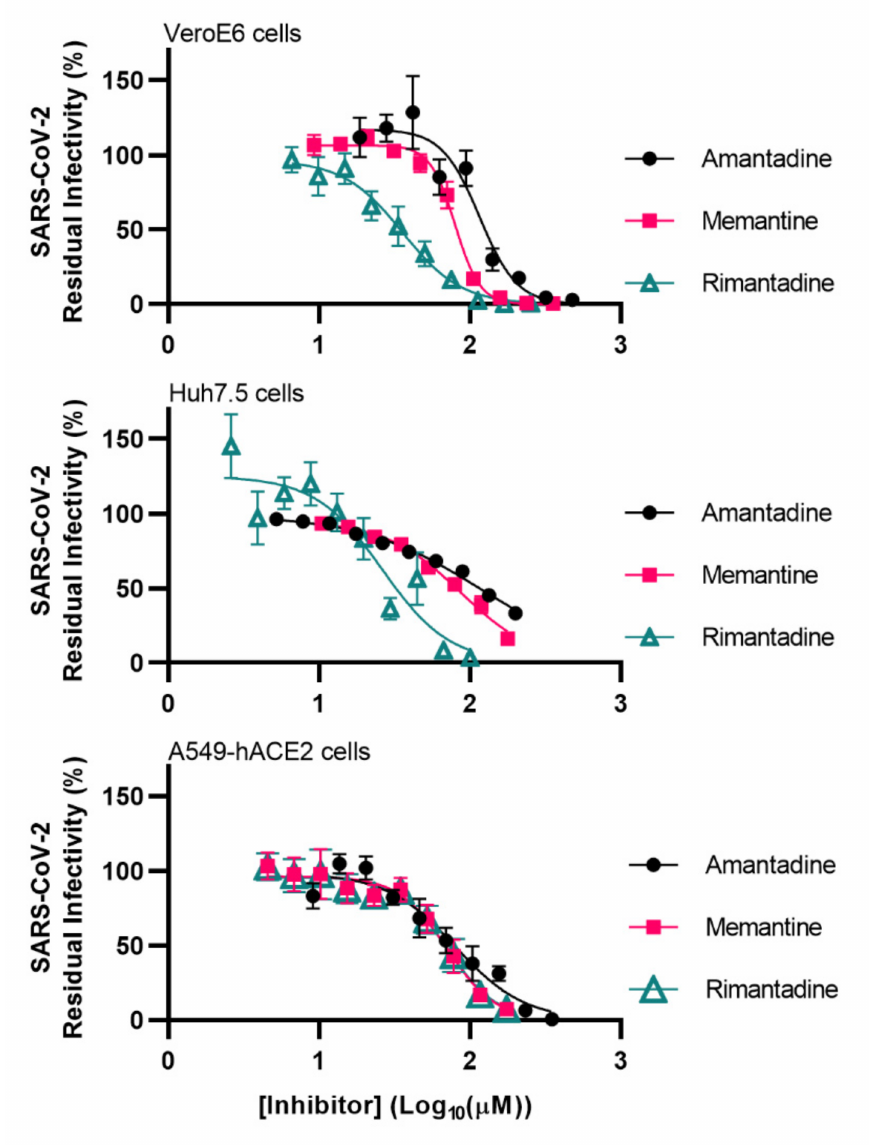
Figure 1. Potency of amantadine, memantine and rimantadine against SARS-CoV-2 in VeroE6 cells, Huh7.5 cells and A549-hACE2 cells. Short-term treatments of SARS-CoV-2 with the specified ion- channel inhibitors were carried out in the specified cell lines in 96-well plates. SARS-CoV-2 infected cells were visualized by immunostaining for spike protein and quantified by automated counting. Datapoints are means of counts from 7 replicate cultures ± SEM and represent % residual infectivity, determined as % SARS-CoV-2 positive cells relative to means of counts from infected-nontreated con- trol cultures. Sigmoidal concentration-response curves were fitted and EC50 values were determined using Graphpad Prism 8.0.0 applying the formula Y = Top/(1 + 10 (Log10EC50-X)*HillSlope ). The tested inhibitor concentrations did not affect cell viability (Figures